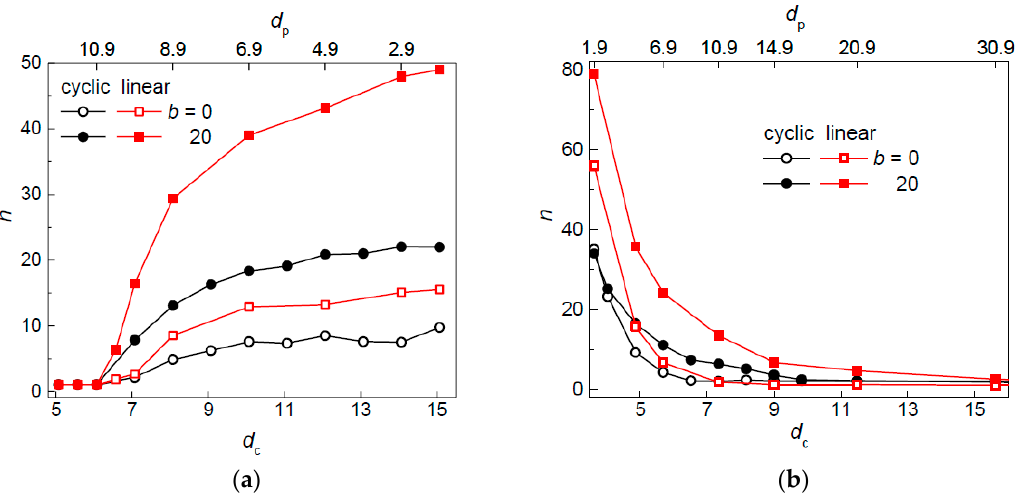
Figure 3. Occupation number of a flexible ( b = 0) and semiflexible ( b = 20) circular and linear chain in an array of posts of varying diameters d p separated by S p = 12 ( a ) and with passage width w p = 2 ( b ) as a function of the size of the interstitial space. The trends in the upper abscissa are reversed when compared to 3a and 3b due to the different way of varying the geometry of the post array as defined in the main text of the manuscript.